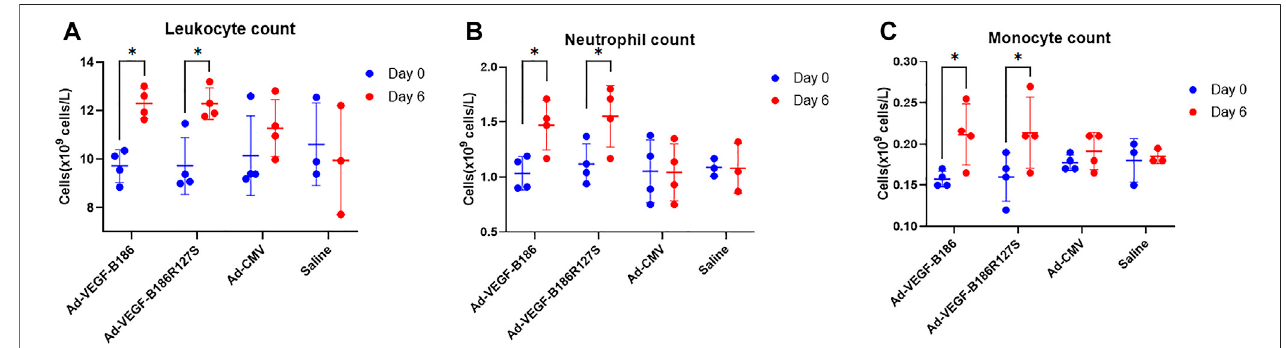
FIGURE 5 | White blood cell analyses. (A) Comparison of leukocyte count from blood 6 days after gene transfer. (B) Comparison of neutrophil count from blood 6 daysaftergenetransfer. (C) Comparisonofmonocytecountfromblood6 daysaftergenetransfer.Eachdotindicatesonemouse; n =4inAd-VEGF-B186, n =4inAd- VEGF-B186R127S, n = 4 in Ad-CMV, and n = 3 in saline groups. Horizontal bars indicate mean ± SD and p values vs. each group by two-way ANOVA, followed by Sidak ’ s multiple comparison test.